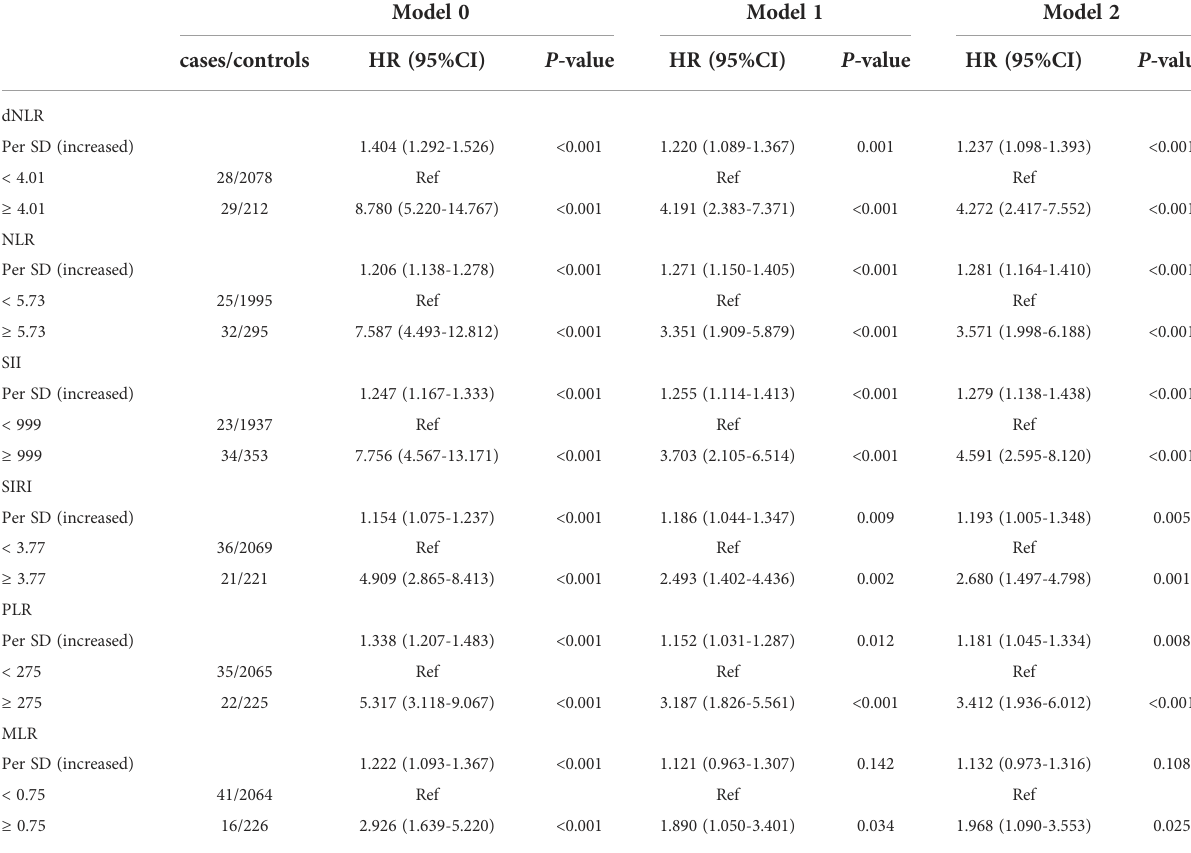
TABLE 2 Univariate and multivariate cox analyses of in fl ammatory indicators in the COVID-19 Omicron BA.2 infected patients. Model